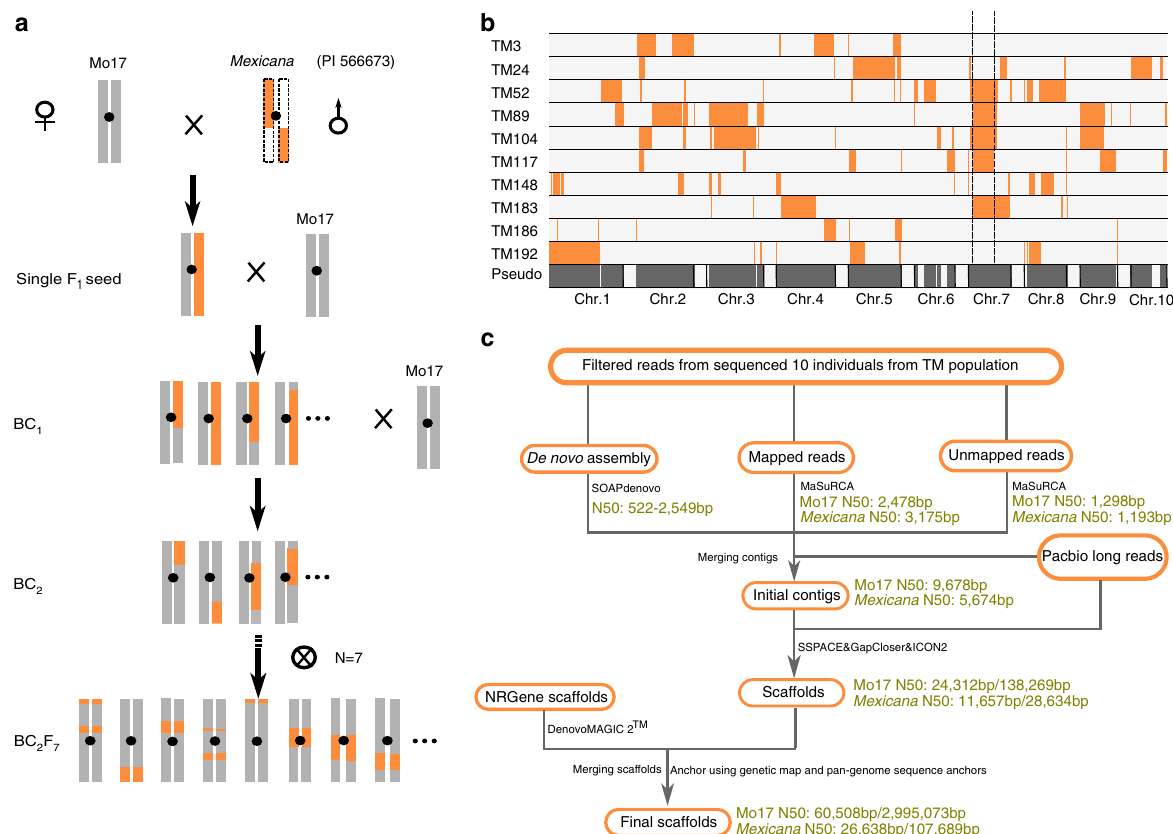
Fig. 1 Mo17- mexicana population development and characterization of the assembled genomes. a The construction of Mo17- mexicana BC 2 F 7 population. Only a single F 1 seed was used. b The genetic design for meta-assembly of the Mo17 and mexicana genomes. Ten well-chosen TM lines that genetically divided the Mo17 and mexicana genomes into different fragments. The fragment indicated by the dash lines are used to estimate the mutation rate in mexicana . c Schematic illustration of the meta-assembly pipeline. The Illumina reads were fi ltered and adapters were removed for each library and the assembly can be divided into three major steps: Step 1, three strategies were used to assemble contigs, including de novo assembly of 10 individuals, reference-based assembly based on B73 genome and de novo assembly of unmapped reads. Step 2, the contigs obtained from the three strategies were merged, and further connected or extended with Pacbio long reads. Long mate-pair libraries were then added to assemble scaffolds. Step 3, the NRGene scaffolds were integrated, and the merged scaffolds were the fi nal scaffolds. The number represents contig length before diagonal and scaffold length after